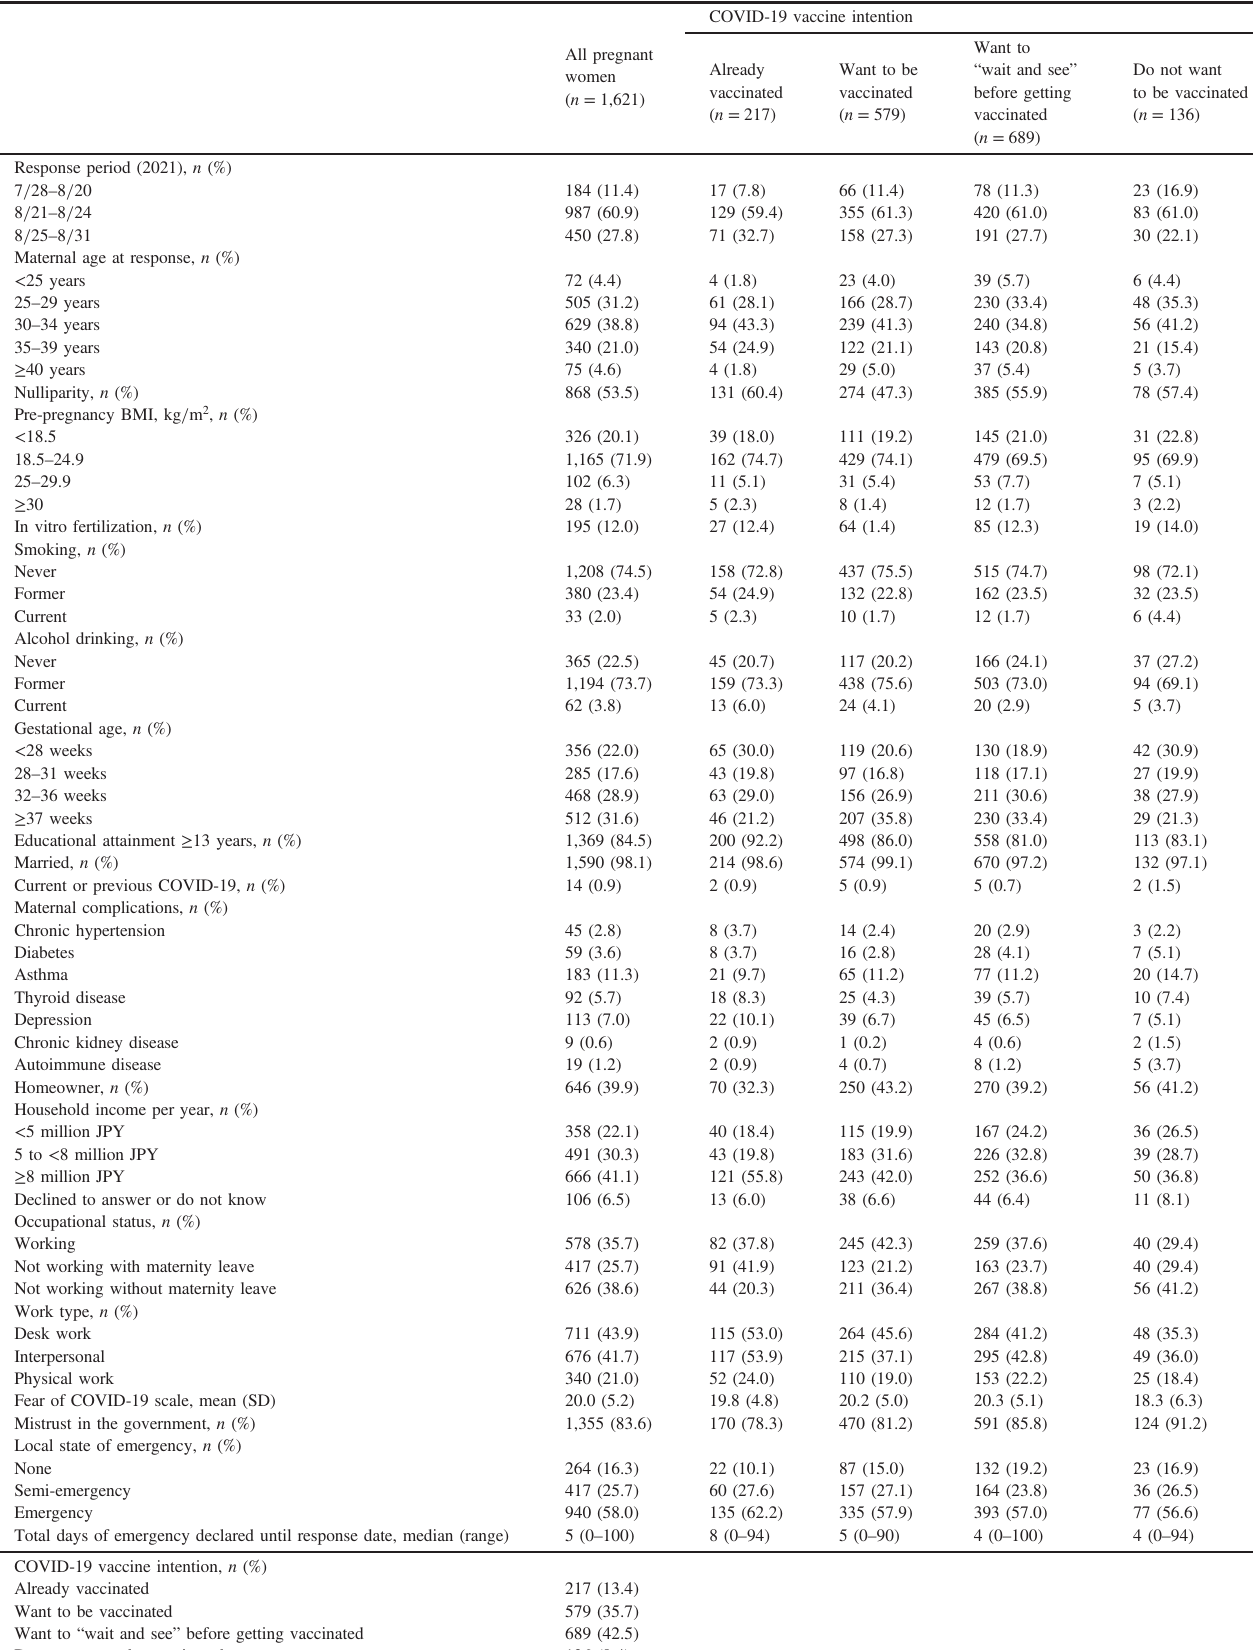
Table 1. Demographic and medical characteristics of pregnant women included in the analysis